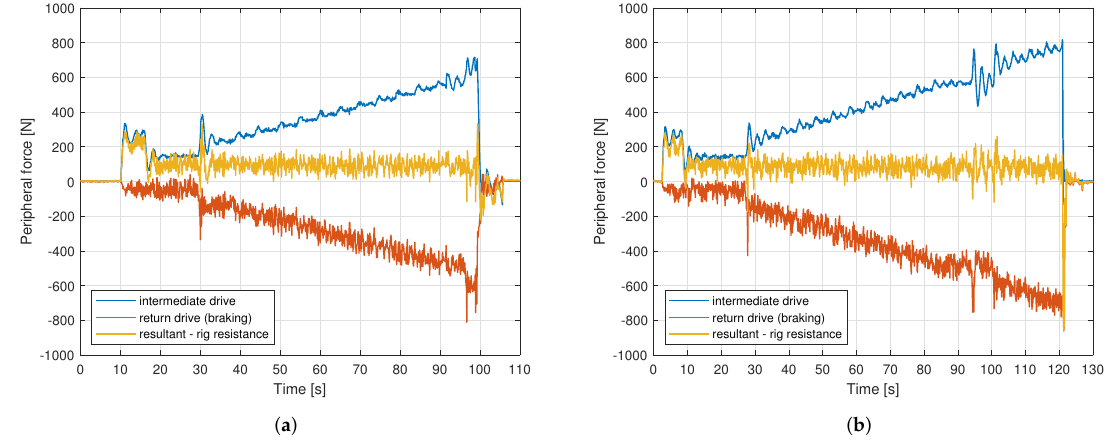
Figure 7. Increase of the peripheral force at the intermediate drive, braking (main) drive and the resultant peripheral force of the system (resistance to motion of the entire conveyor): ( a ) for coupling at the carry side, ( b ) for coupling at the carry and return